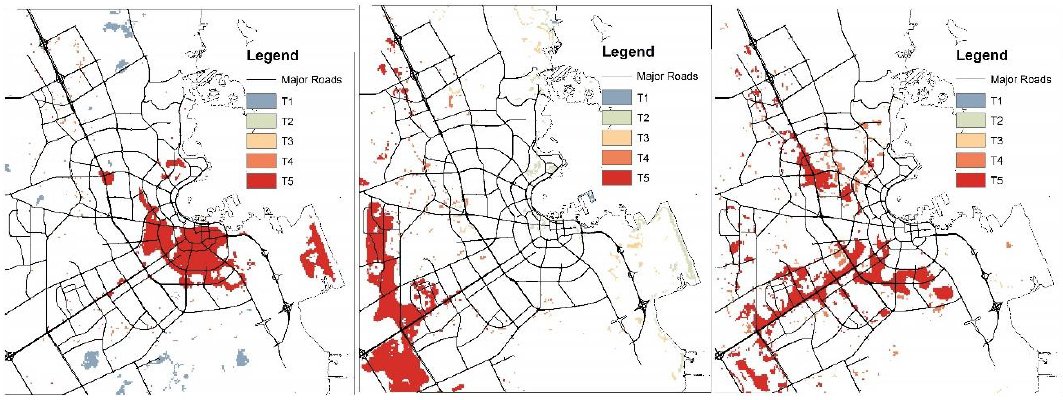
Figure 6. Air temperature variability maps with road maps for five days in each time period: 6 am ( left ); 1 pm ( center ); 7 pm ( right ).